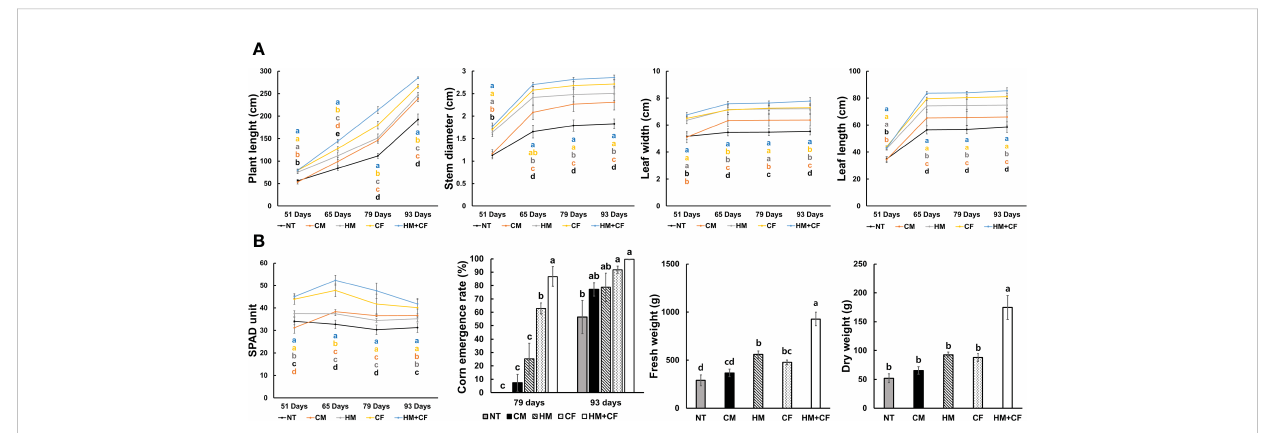
FIGURE 1 Difference in the growth of corn (NT, non-treatment; CM, commercial manure; HM, Hanwoo manure; CF, chemical fertilizer; HM+CF, combined use of Hanwoo manure and chemical fertilizer). (A) Plant length, stem diameter, and the width and length of leaves 93 days after planting. (B) SPAD unit, corn emergence rate, and fresh and dry weight of plant 93 days after planting. The line colors represent the different fertilizer treatments. The values are the mean ± standard deviation (n = 18). The lowercase letters represent the signi fi cant differences (p < 0.05) between groups using the Duncan